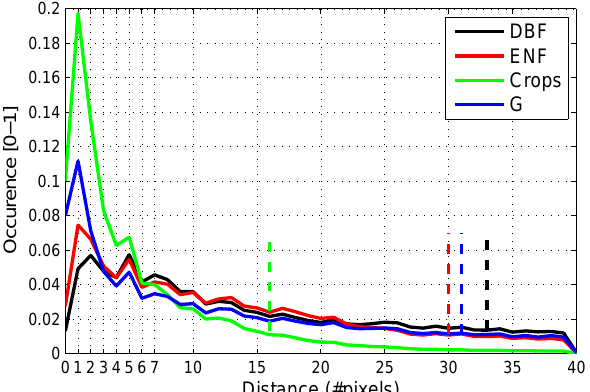
Fig. 15. Distance (# pixels) to nearest homogeneous pixel by PFT, i.e. C3 crops (black), DBF (red), ENF (blue), G (green), in Europe. Vertical dashed lines denote the 90% of the cumulative distribution for each PFT (based on ECOCLIMAP-I).